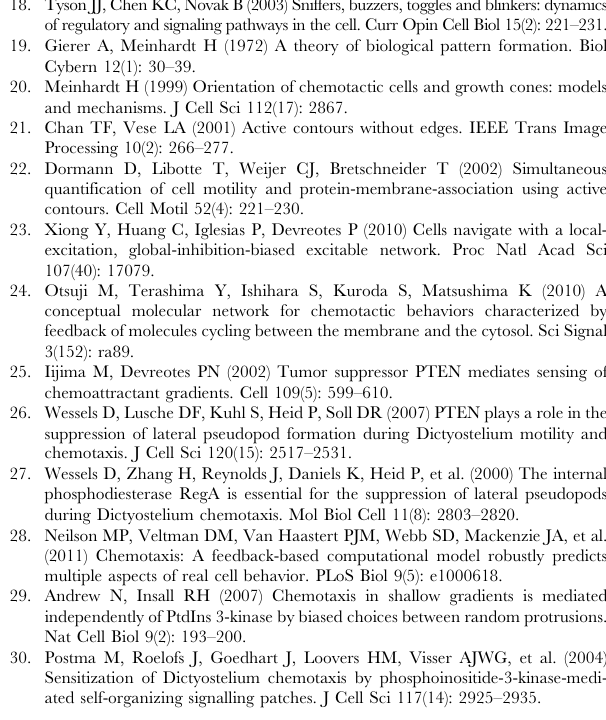
Figure S2 Zig-zag statistics excluding pseudopods with smaller turning angles. The group of bars on the left display statistics including all pseudopods as reported in Results, and